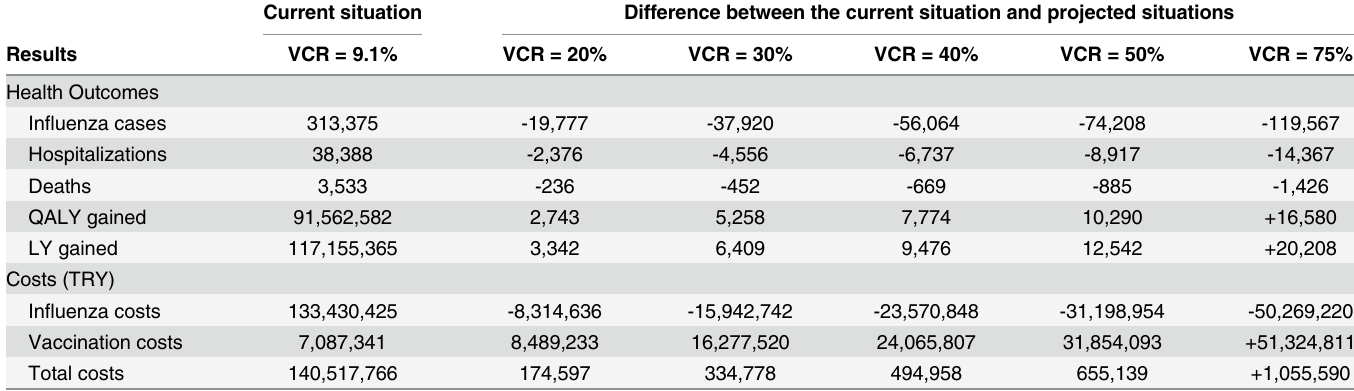
Table 2. Projected health outcomes and costs of different VCRs in Turkish adults with diabetes.